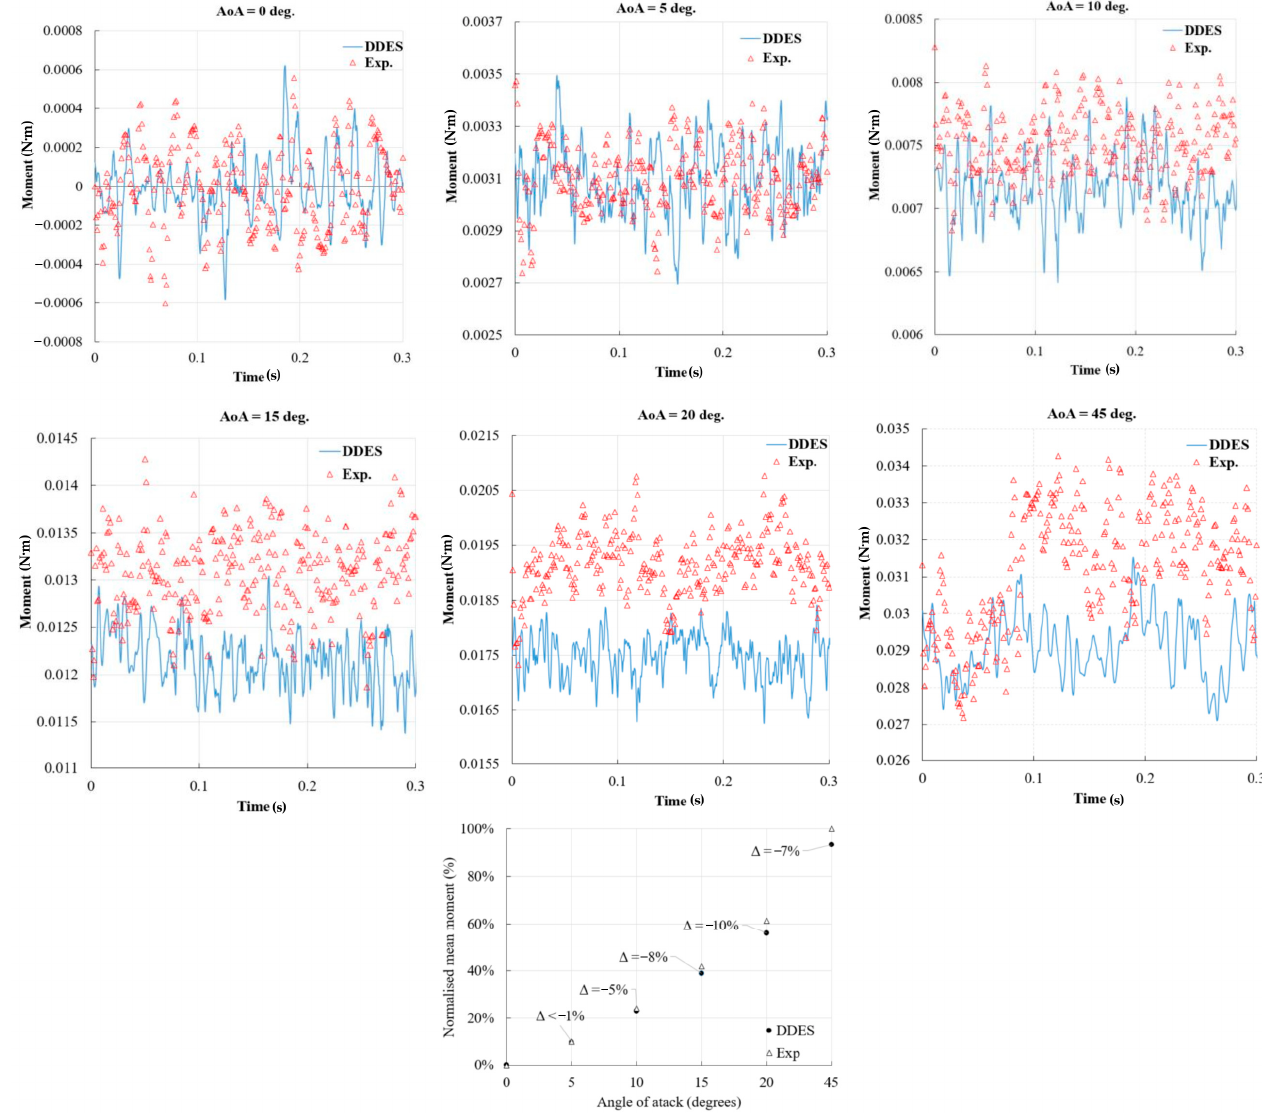
Figure 7. Instantaneous moment for measured cases and normalized mean moment from angle of a tt ack.